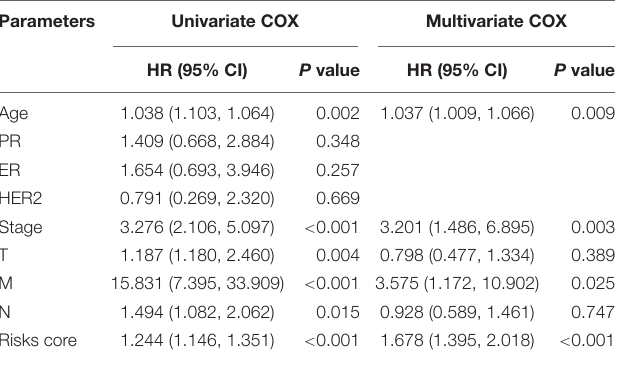
TABLE 1 | COX regression analysis of the 3-APA-event signature with OS. TABLE 2 | COX regression analysis of the 8-APA-event signature with